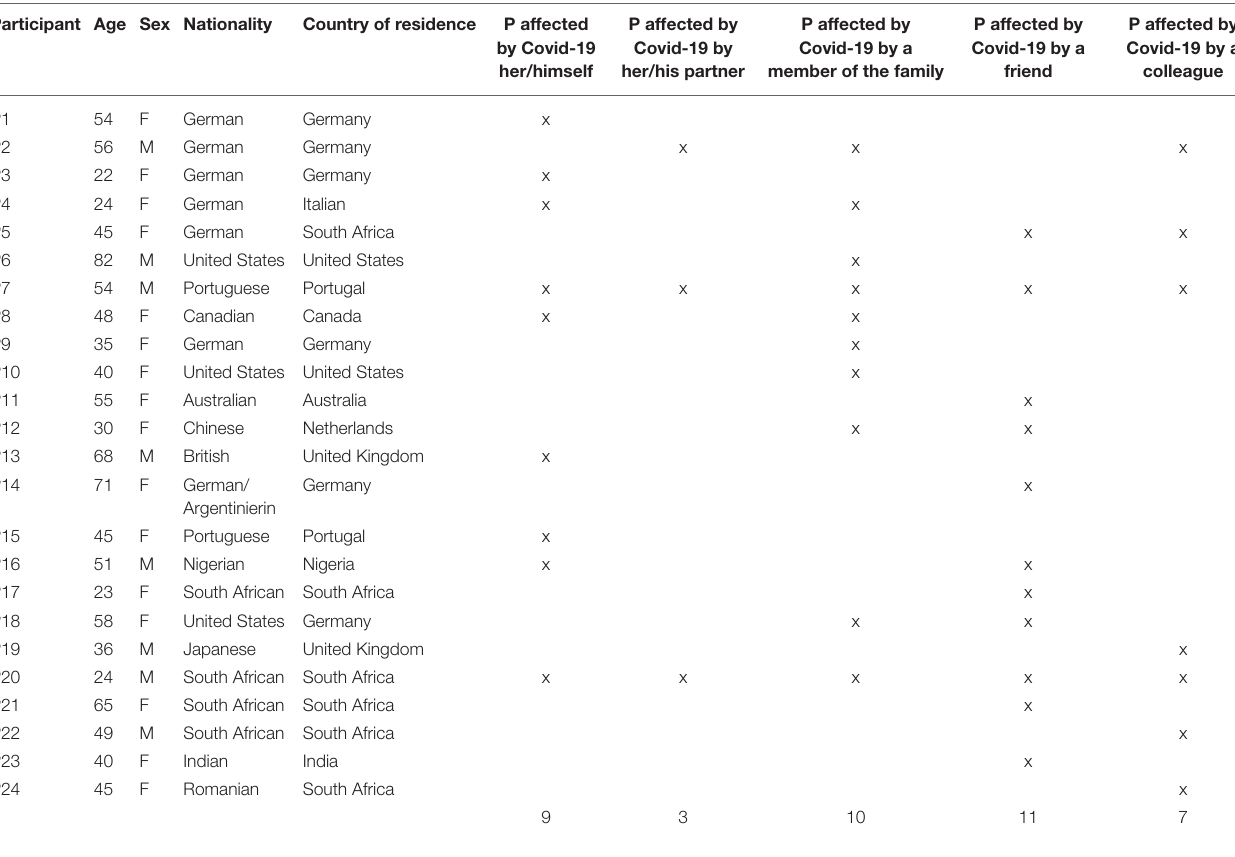
TABLE 1 | Biographical